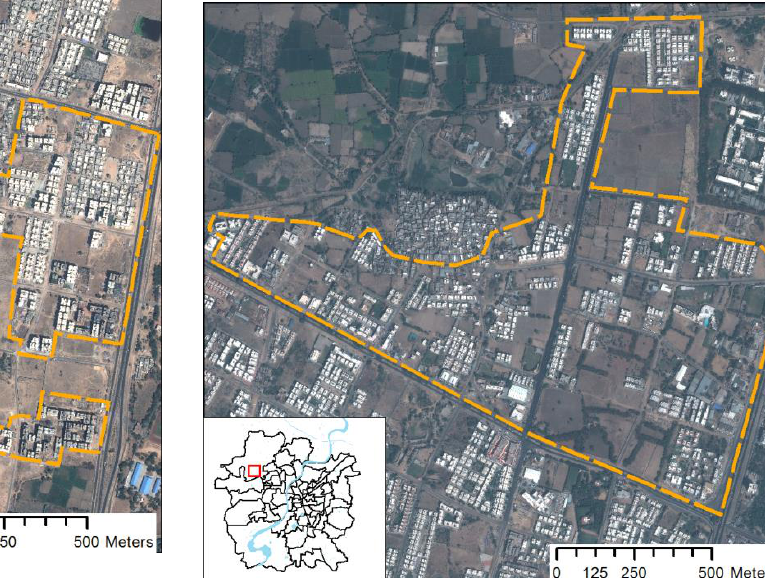
Figure 7: Investigated area of Ward 50